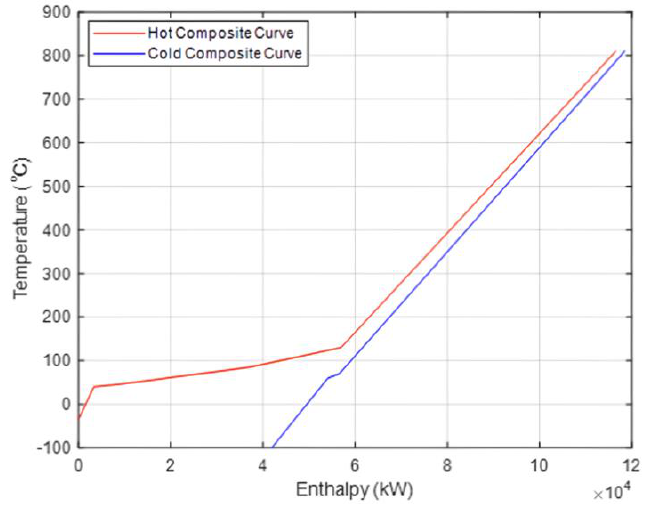
Figure 7. Thermal pinch diagram at ∆𝑇 𝑚𝑖𝑛 = 25 ℃ .